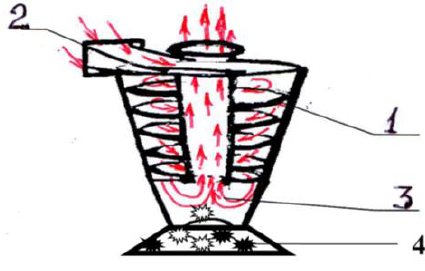
Fig. 2. Mechanical cleaning CVFS by CСС: 1– spiral insertion; 2 – cleaning of SA; 3 – exit from the insertion of SA; 4 – container with particulate dispersible compounds